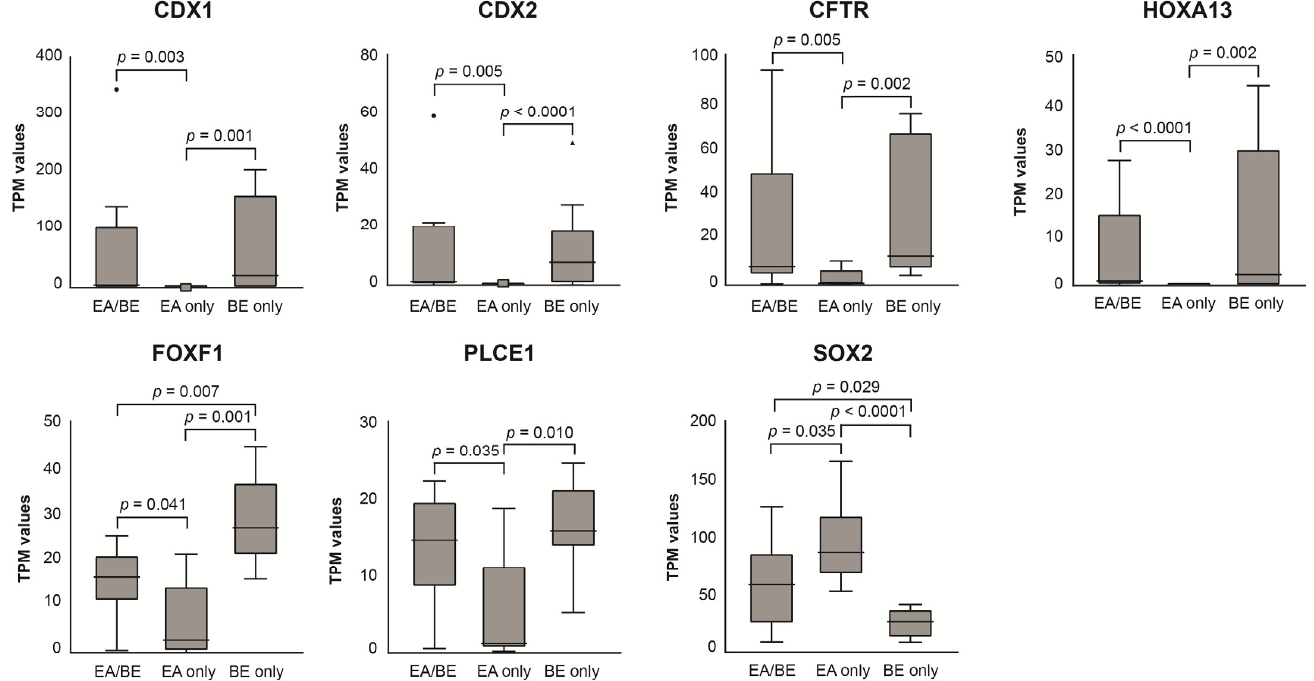
Figure 3. Gene expression levels per group for selected disease genes, involved in foregut morphogenesis and/or associated with Barrett’s esophagus in literature, presented as median (interquartile range) with minimum and maximum values. We compared biopsies of the gastroesophageal junction between three groups of patients: patients with esophageal atresia (EA) who have developed Barrett’s esophagus (BE) (EA/BE, n = 11), patients with EA without BE (EA-only, n = 10), and patients with BE without EA in history (BE-only, n = 10). TPM = transcripts per million, EA = esophageal atresia, BE = Barrett’s esophagus.